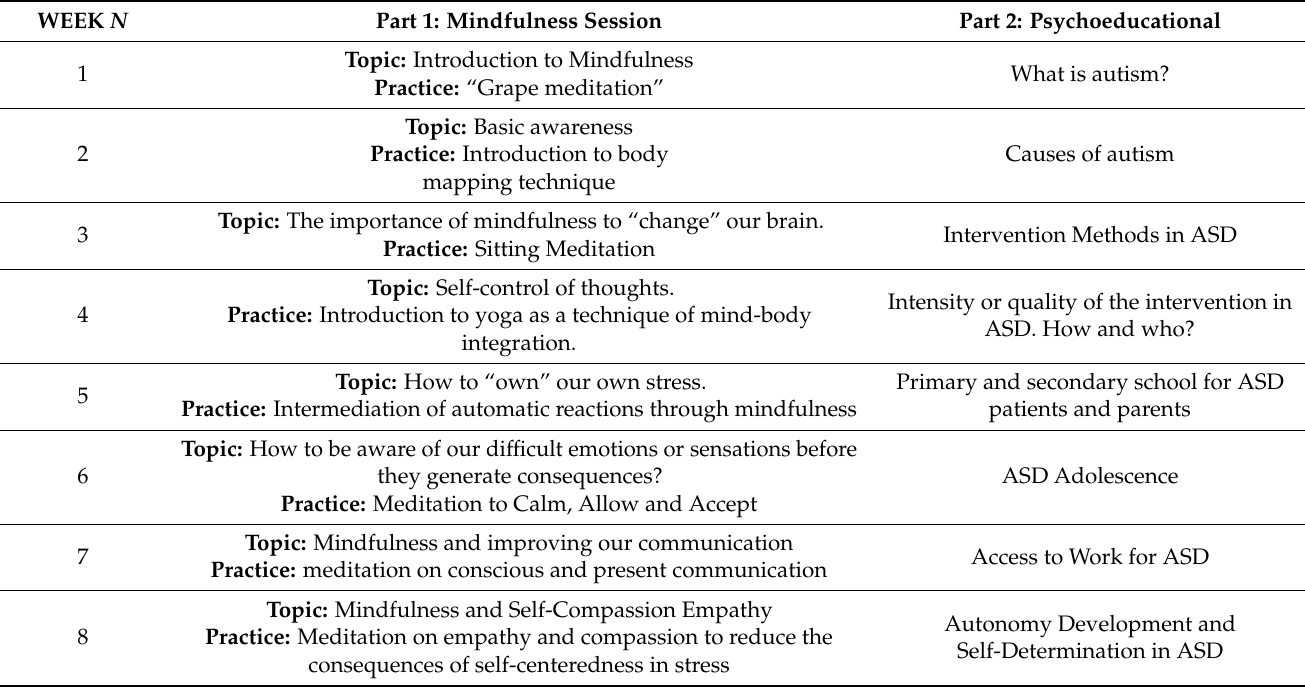
Table 2. Topics and practices done in both mindfulness and parts of the face-to-face